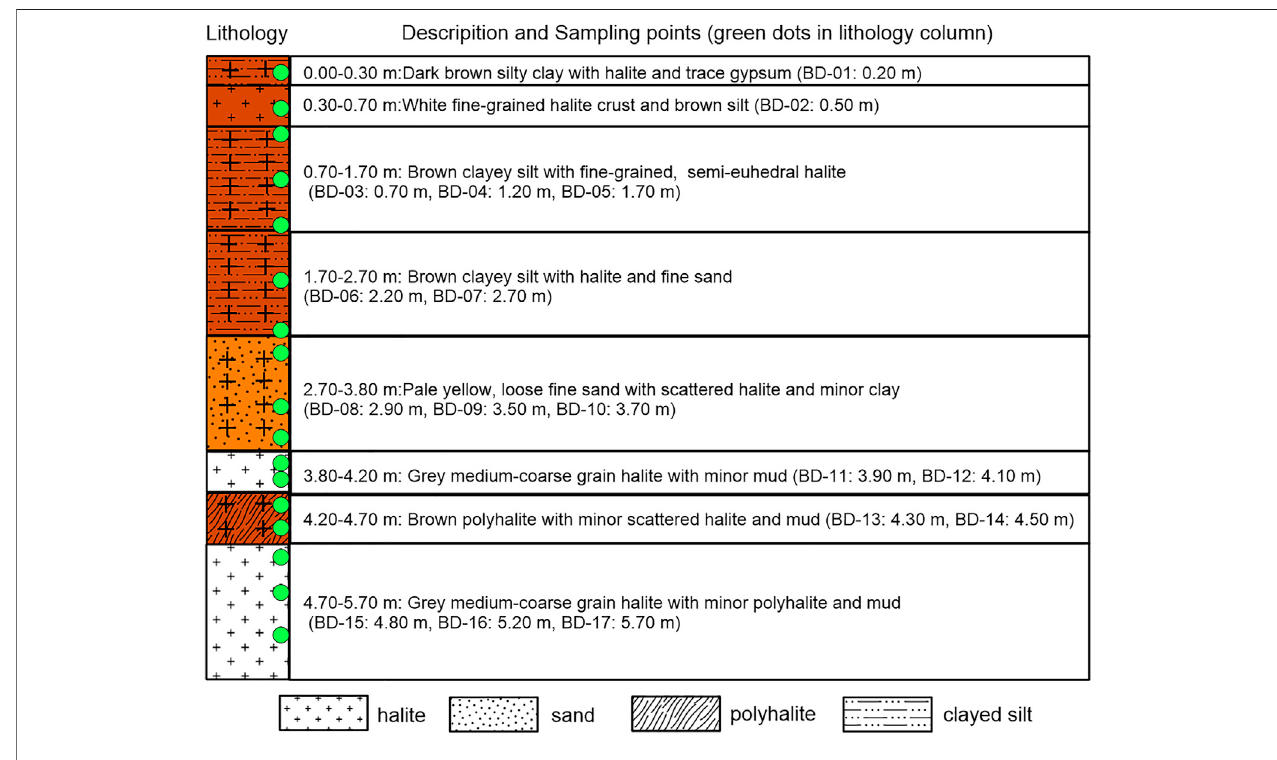
FIGURE 2 | Section showing position and lithological division in study